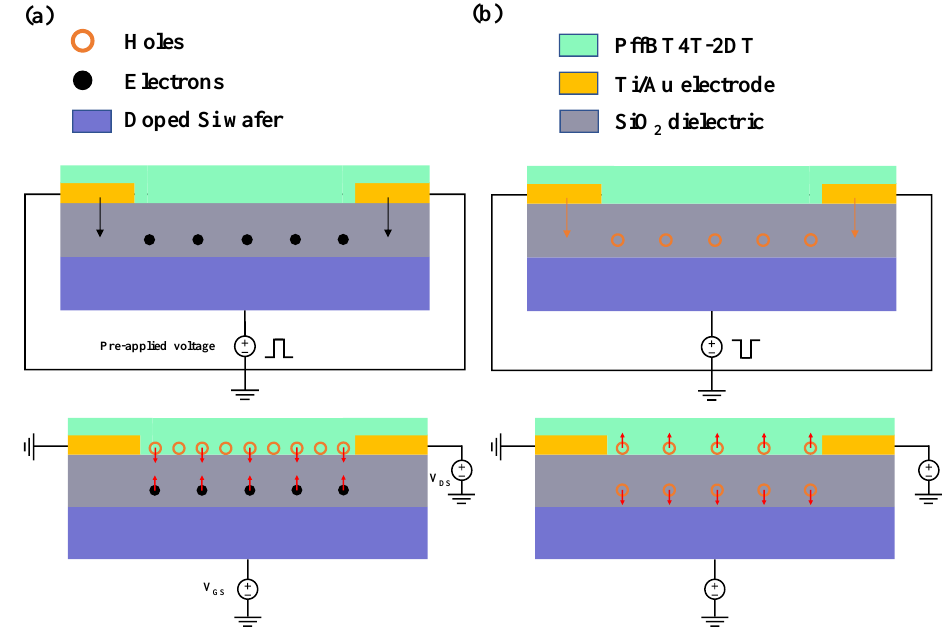
Figure 4. Operation model for shift threshold voltage: ( a ) pre-applied positive gate voltage and ( b ) negative voltage.